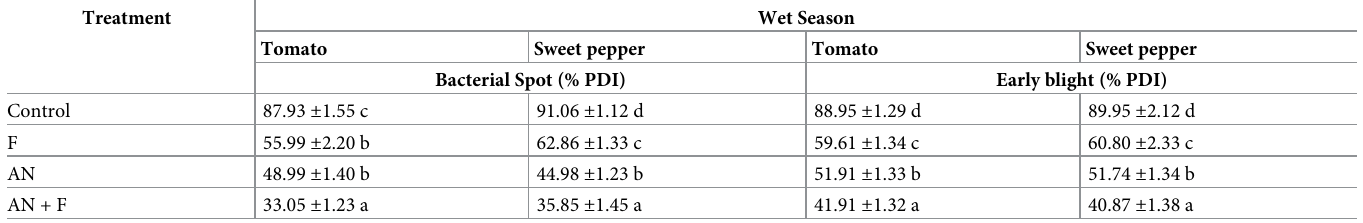
Table 5. Effect of A . nodosum extract application on disease severity on field-grown tomato and sweet pepper in the wet season.